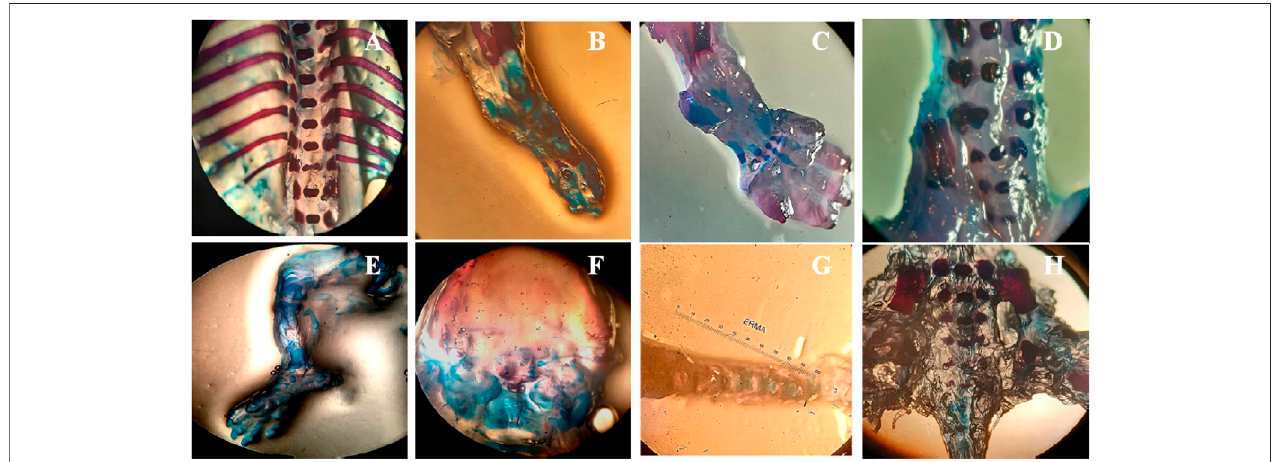
FIGURE 3 | Effect of SF1 treatment (40 mg/kg) on skeletal anomalies in the teratogenic study. (A) : no ribs fusion, (B) : ossi fi ed hind limb bone, (C) : ossi fi ed bone of forelimb, (D) : normal legs bone, (E) : palate bone, (F) : normal cleft palate, (G) : tail bone, (H) : lower vertebral column.